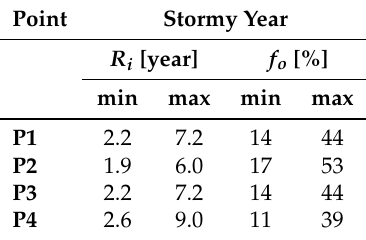
Table 3. Stormy year recurrence interval ( R i ) and yearly frequency of occurrence ( f o ) calculated from Equation (4), considering yearly cumulative energy values (Figure 9), for each prediction point (Table